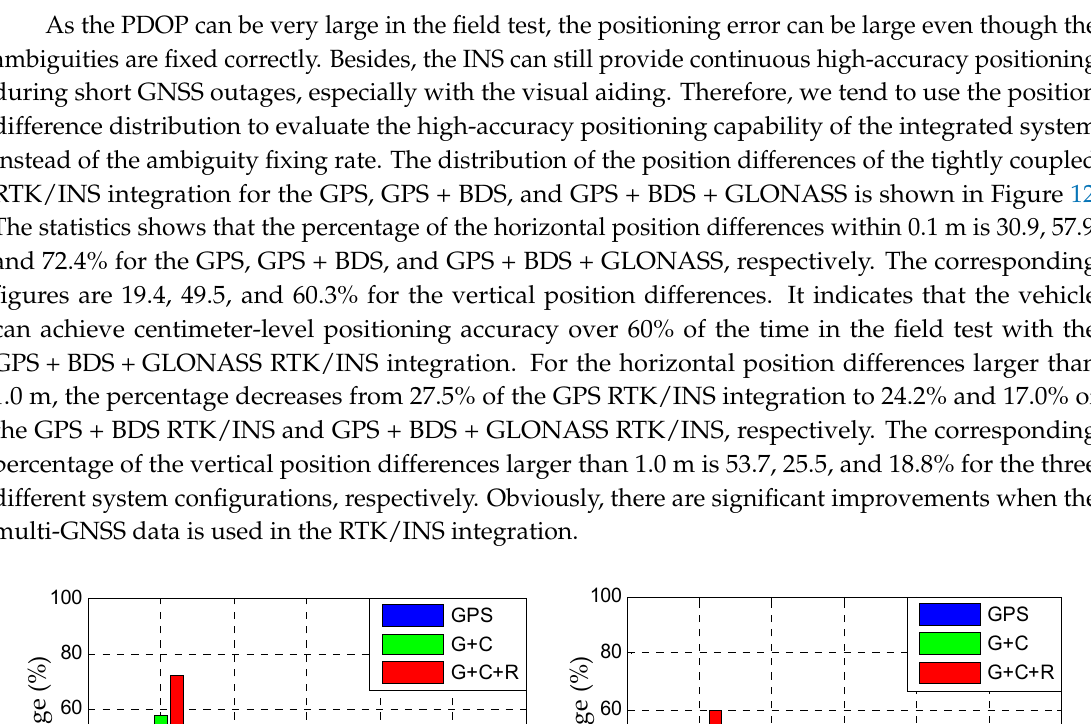
[0.0,0.1][0.1,0.3][0.3,0.5][0.5,1.0]